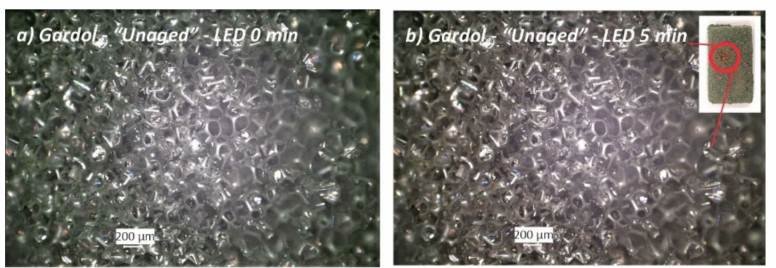
Figure 6. Open-cell “Unaged” Gardol foam sample before ( a ) and ( b ) after five minutes of LED illumination of the optical microscope used for the observation and documentation of the materials. Brown areas caused by the LED illumination are shown in ( b ) and circled in red in the foam sample image on the top right.